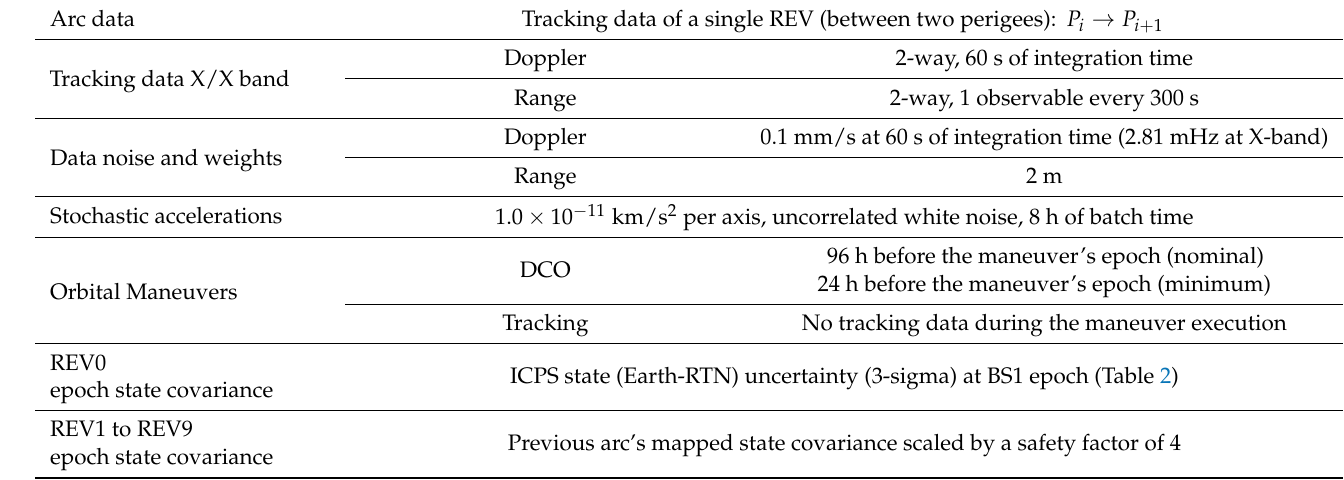
Table 5. Baseline OD